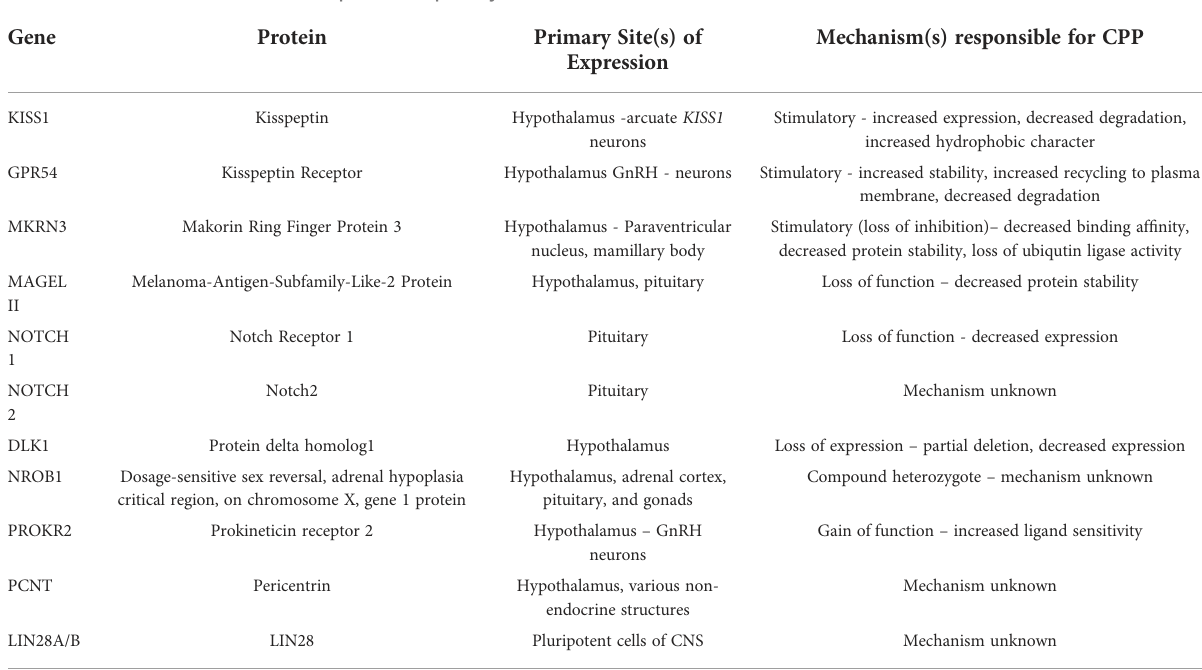
TABLE 1 Genes associated with central precocious